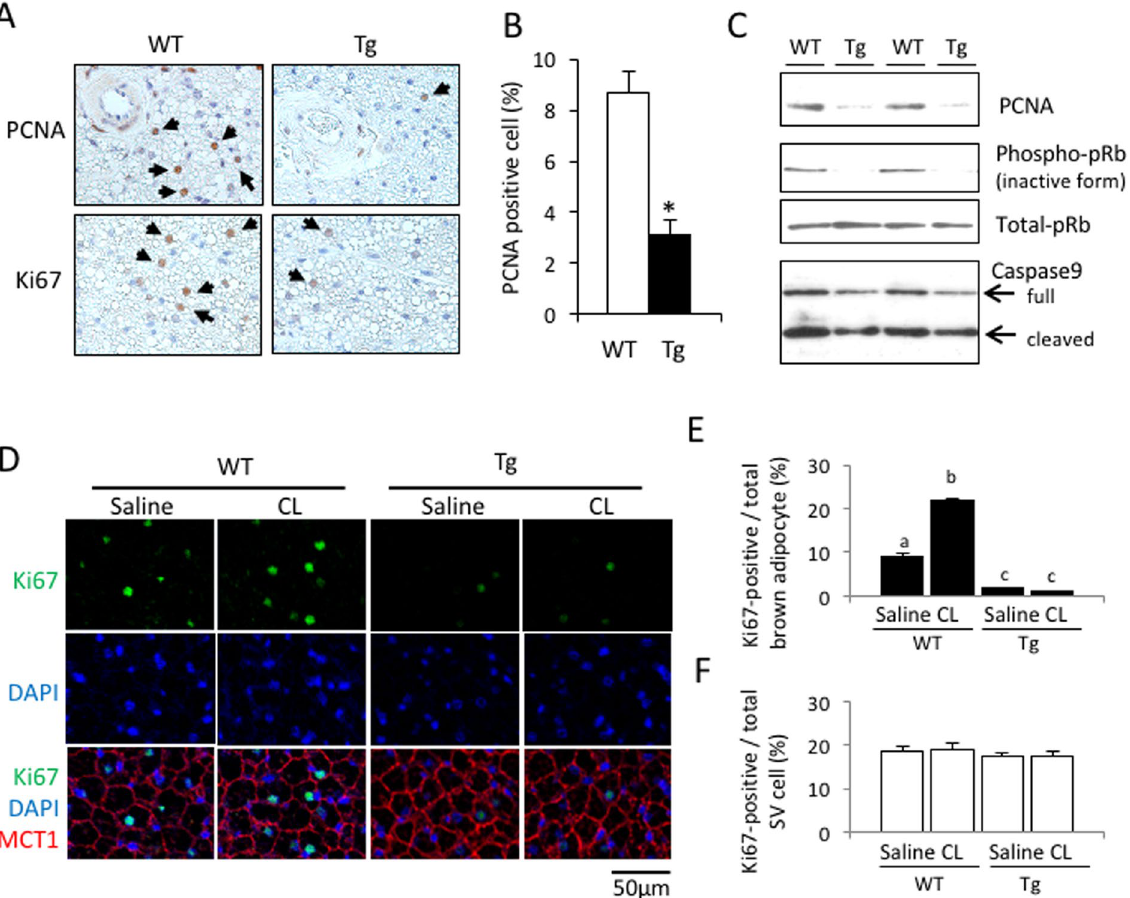
Figure 3. Transgenic expression of p27 driven by the aP2 promoter suppressed cell proliferation in BAT. ( A – C ) Representative images of BAT sections from Tg mice show a lower expression of the cell proliferation markers, PCNA and Ki67, compared to WT mice ( A ). Quantification of PCNA-positive cells ( B ) and western blot analyses ( C ) in the BAT confirmed decreased expression of proliferative markers but there were no essential differences with respect to the apoptosis-related protein (n = 5 per group, Student’s t-test, * p < 0.05). ( D – F ) Mice were injected with the β 3-adrenergic agonist CL316,243 (CL; 0.1 mg/kg, s.c.) and BAT was sampled 24 h later. Representative images of BAT sections stained with the Ki67 antibody, along with the MCT1 antibody and DAPI, ( D ) identified mature brown adipocytes as having round nuclei separated from the MCT1-positive cell membrane, and stromal-vascular (SV) cells as having flattened nuclei sandwiched between the MCT1- positive cell membranes 26 . Graphs representing the quantified data show that the number of Ki67-positive brown adipocytes ( E ), but not the number of SV cells ( F ), was much lower in Tg mice, and an increase after CL treatment was observed only in WT mice (n = 4 per group, one-way ANOVA followed by the Tukey–Kramer post-hoc test, different letters indicate significant differences between groups, p <